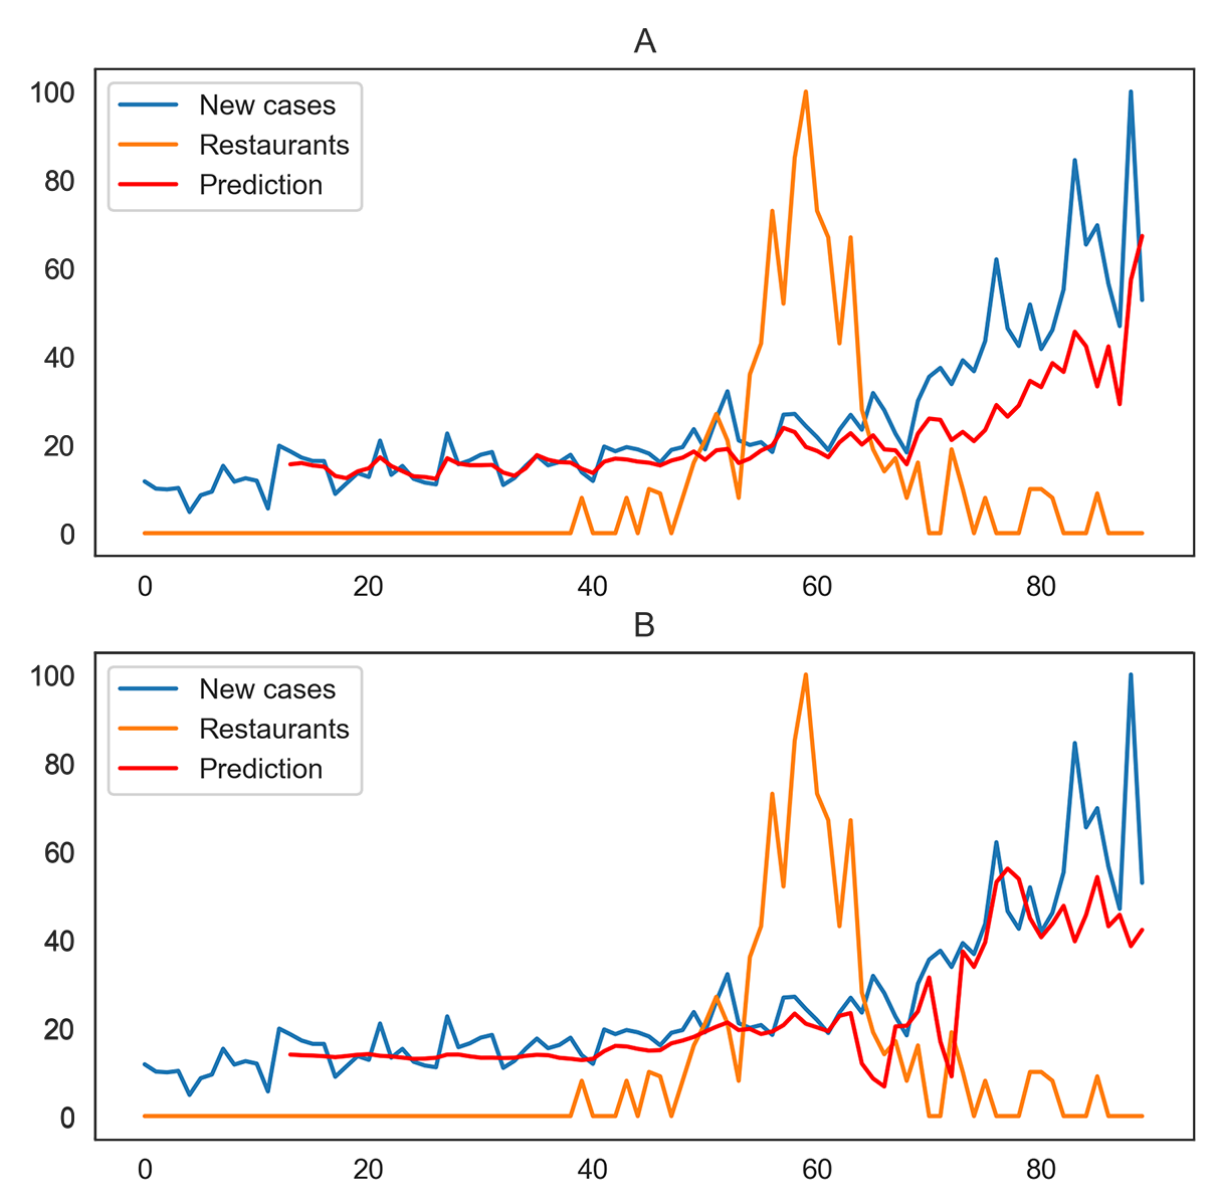
Figure 4. Prediction values for daily new cases of COVID-19 without (A) and with (B) restaurant search trends for California from April 9 to July